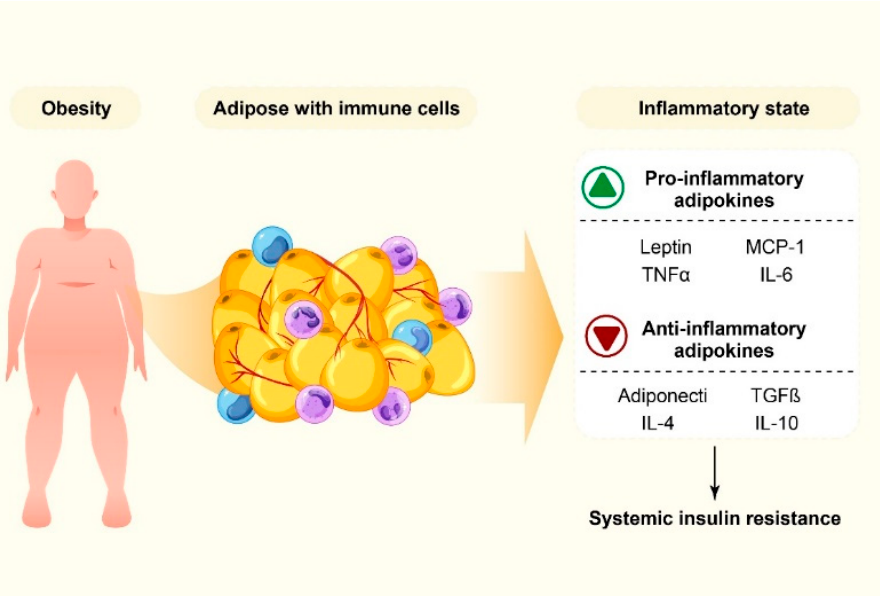
Figure 2. The interplay of inflammation and obesity.